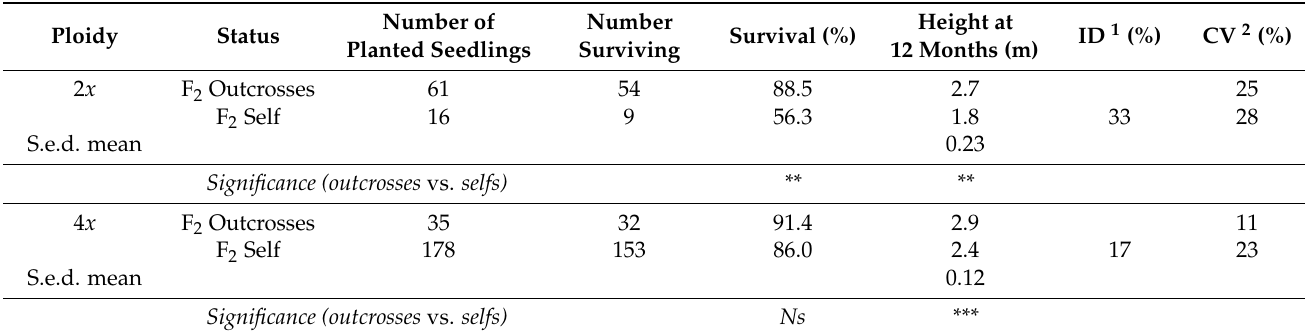
Table 9. Field survival and growth of outcross and selfed progenies of 2 x and 4 x lines after 12 months and estimated inbreeding